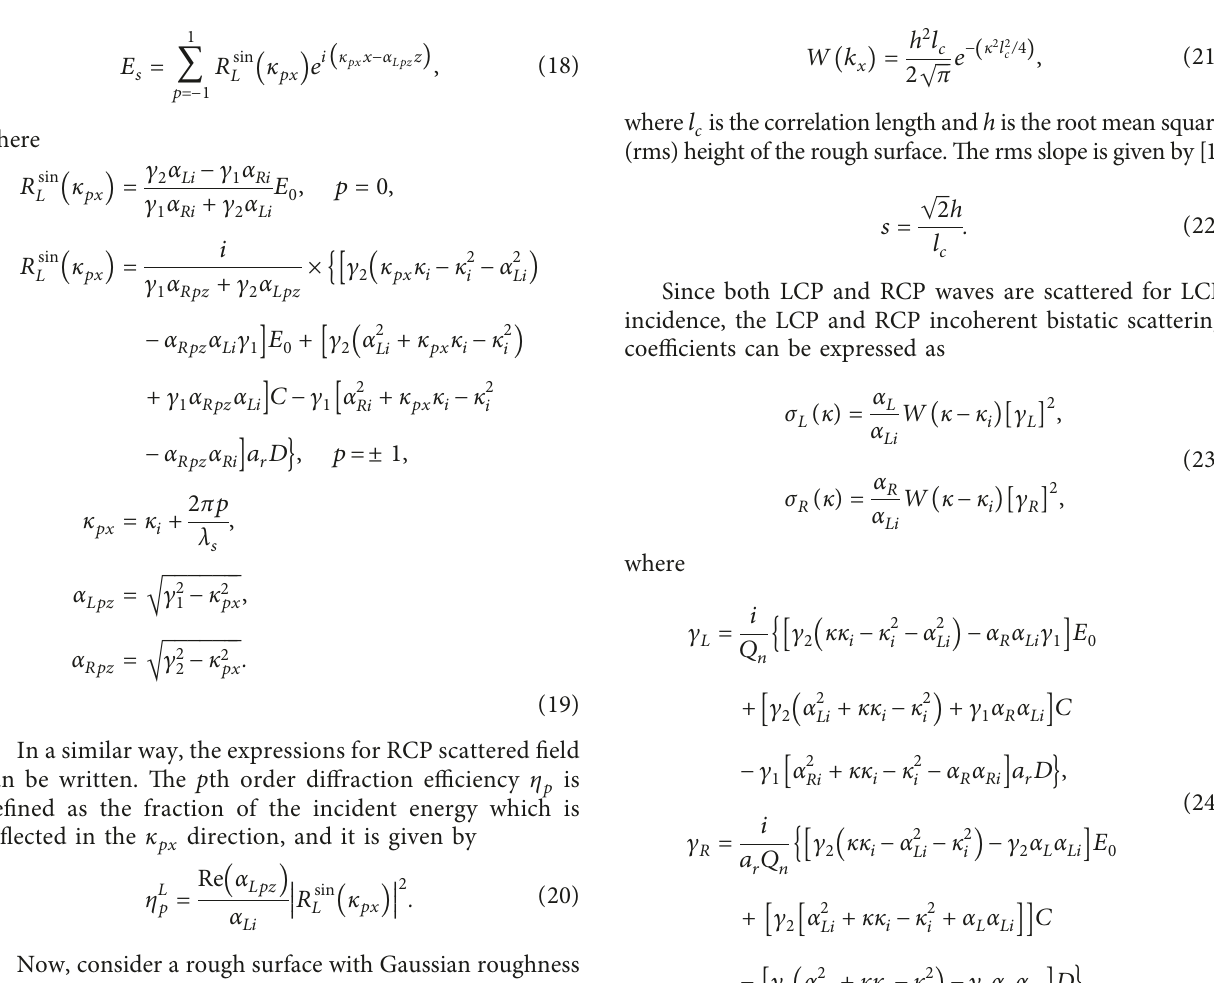
Figure 4: LCP and RCP scattering coefficients for different values of correlation length, where φ